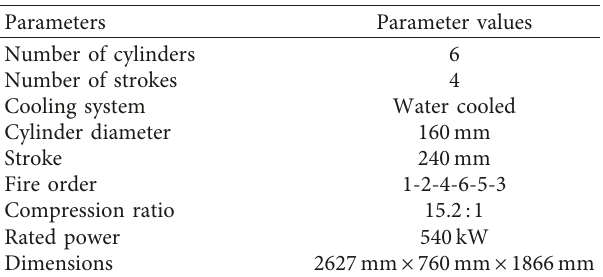
Figure 7: Marine engine Table 4: The main technical parameters of the internal combustion engine.